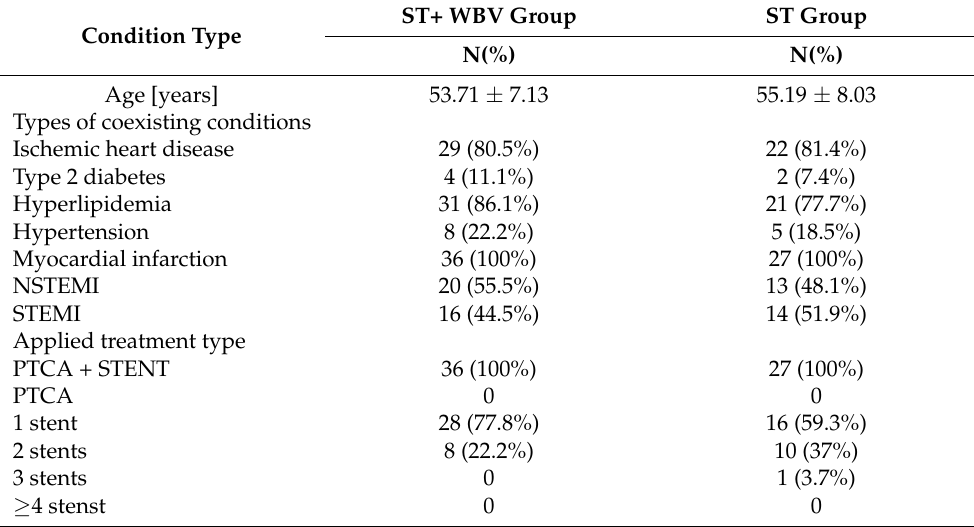
Table 2. Characteristics of study